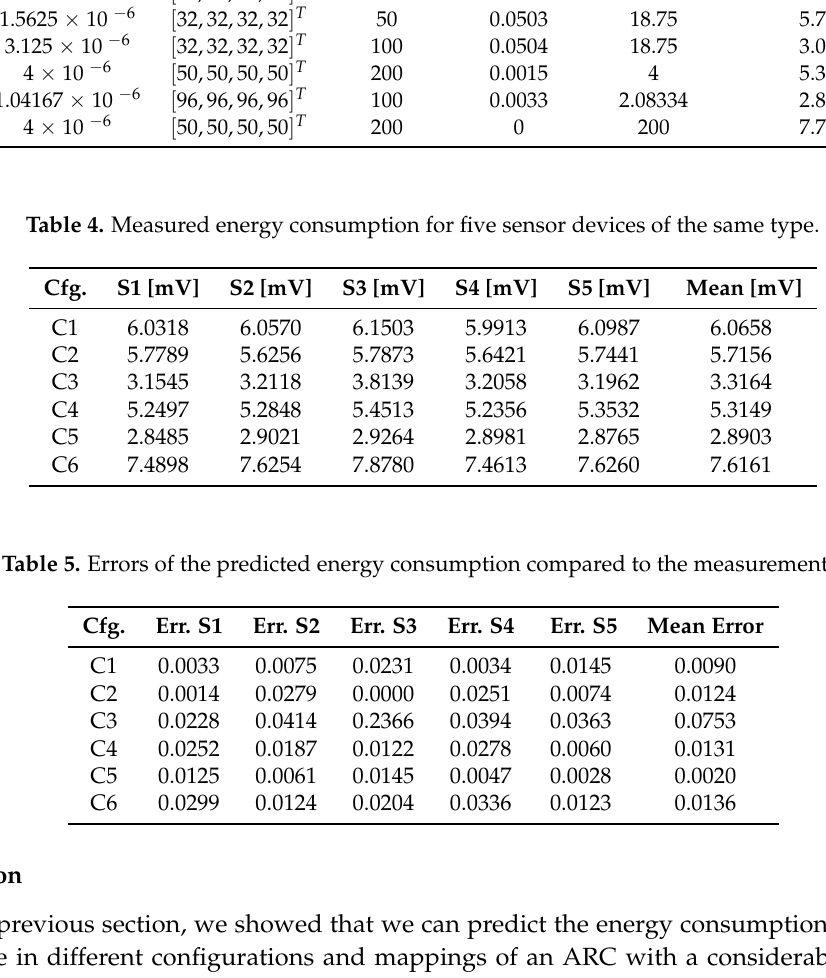
Table 3. Graph-extracted model properties and estimated energy consumption of all configurations. Cfg. TH [ µ s − 1 ] rep . vec . T ef trans ( t 1 ) Ref.